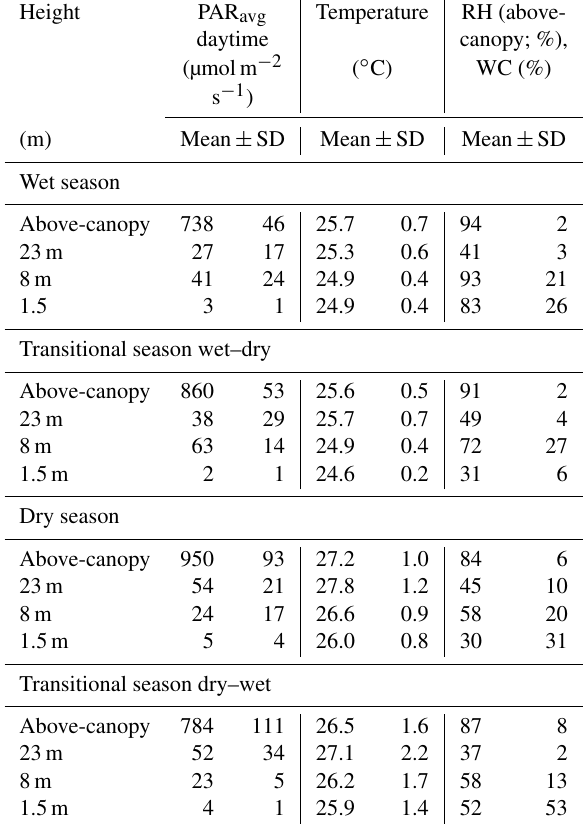
Table 2. Seasonal mean values and standard deviations ( ± SD) of the mean photosynthetically active radiation (PAR avg ), the temper- ature, and the above-canopy relative humidity (RH) or water content (WC) of bryophytes determined at different height levels and above the canopy. Mean values for the respective seasons were calculated from 30min intervals from October 2014 to November 2016. Val- ues for PAR max can be found in Table S7.